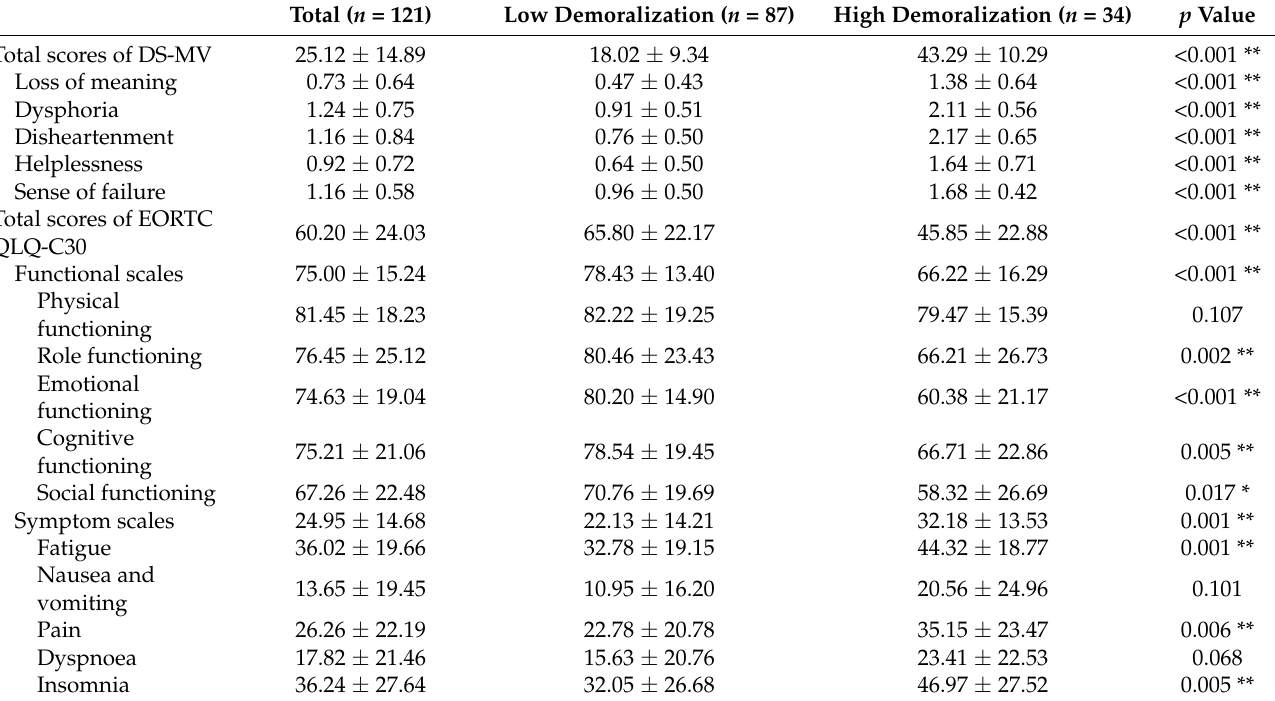
Table 2. The associations between variables of rating scales and